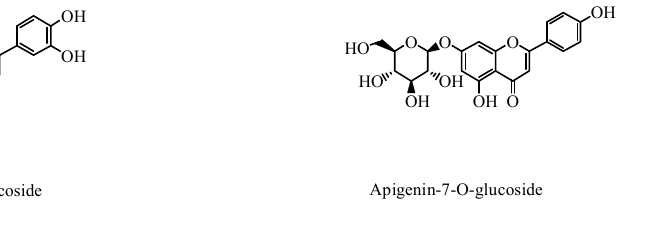
Figure 3. Active flavonoids in P. grandiflorus. Table 1. The other flavonoids components isolated from P. grandiflorus.